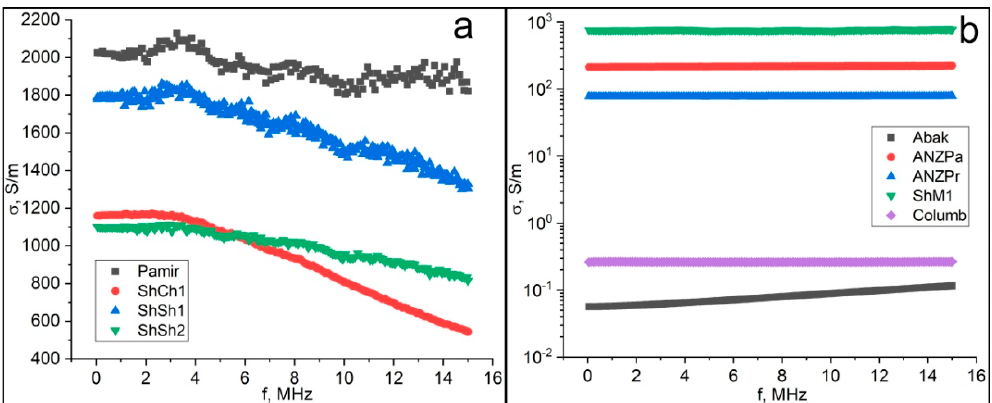
Figure 11. Frequency dependence of the conductivity of the first type ( a ) and the second and third types ( b ). Samples code: Pamir—natural graphite; ShCh1, ShSh1, ShSh2, ShM1—samples of shungite carbon from various occurrences of Karelia; anthraxolites from Kazakhstan (Abak), Novaya Zemlya islands (ANZPa, ANZPr), and Colombia (Columb).